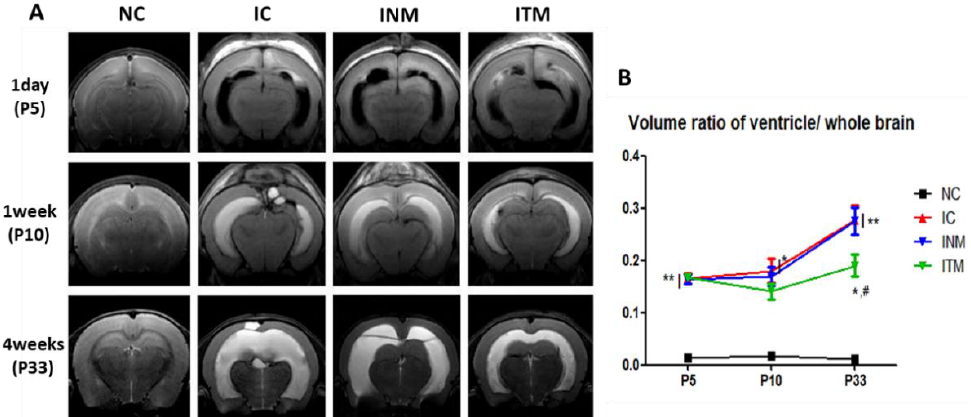
Figure 2. Reduced ventricular dilatation induced by severe IVH observed after transplantation of thrombin-preconditioned MSCs. Transplantation of thrombin-preconditioned MSCs reduced ventricular dilatation after IVH induction. ( A ) Serial brain magnetic resonance images of the four groups and ( B ) ventricle-to-whole brain volume ratio ( n = 18, 29, 23, 28 in the NC group, IC group, INM group and ITM group, respectively). Data are expressed as means ± SEM. * p < 0.05 and ** p < 0.01 compared to the NC group, # p < 0.05 compared to the IC group. NC, normal control; IC, IVH control; INM, IVH with transplantation of naïve MSCs; ITM, IVH with transplantation of thrombin-preconditioned MSCs; IVH, intraventricular hemorrhage; MSCs, mesenchymal stem cells; SEM, standard error of the mean.